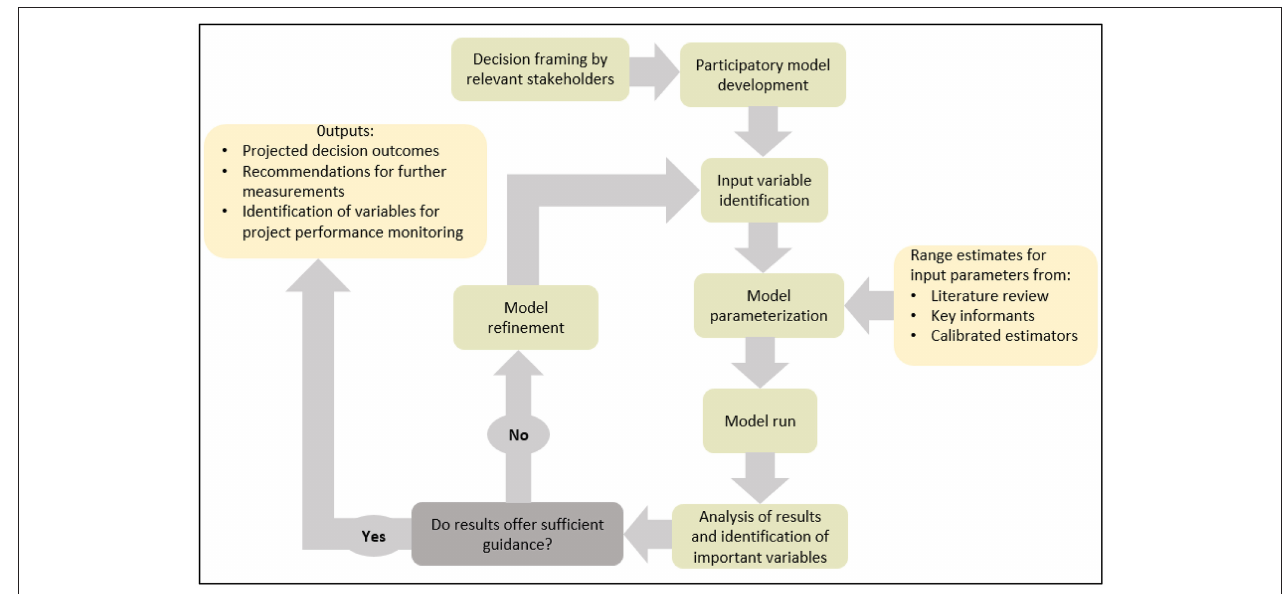
FIGURE 2 | Sequence of activities in the SIE decision modeling approach (modified from [8]).